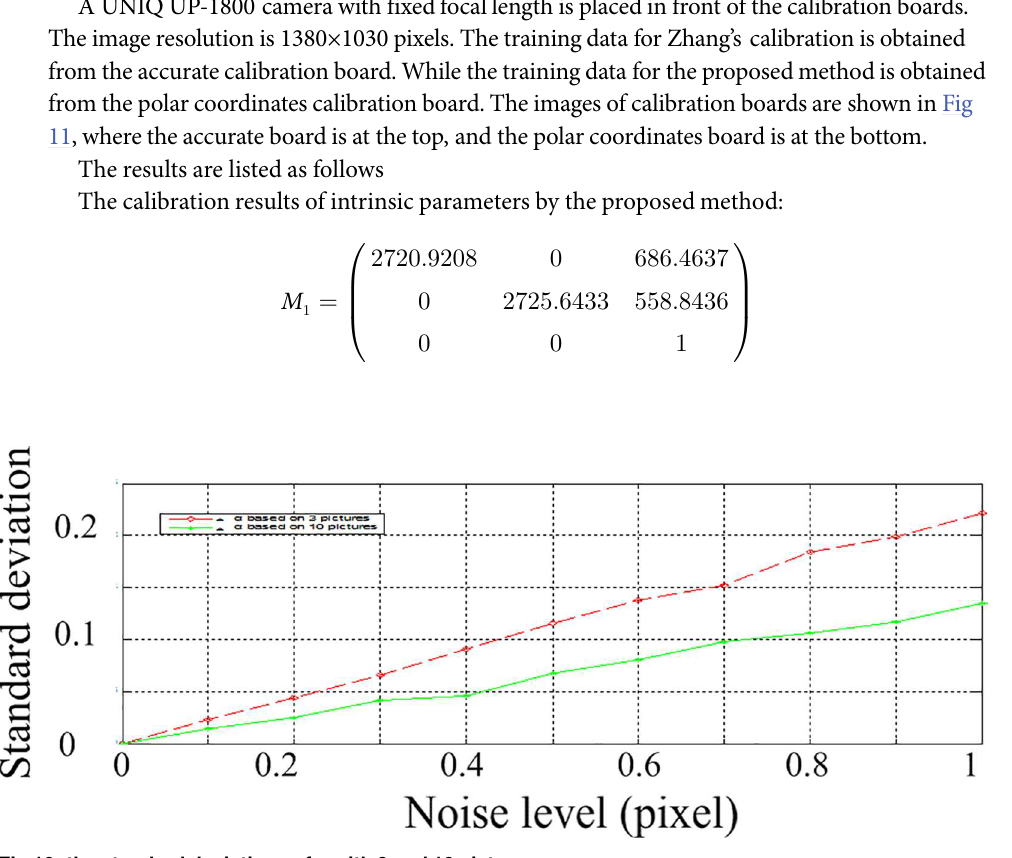
Fig 10. the standard deviations of α with 3 and 10 pictures.